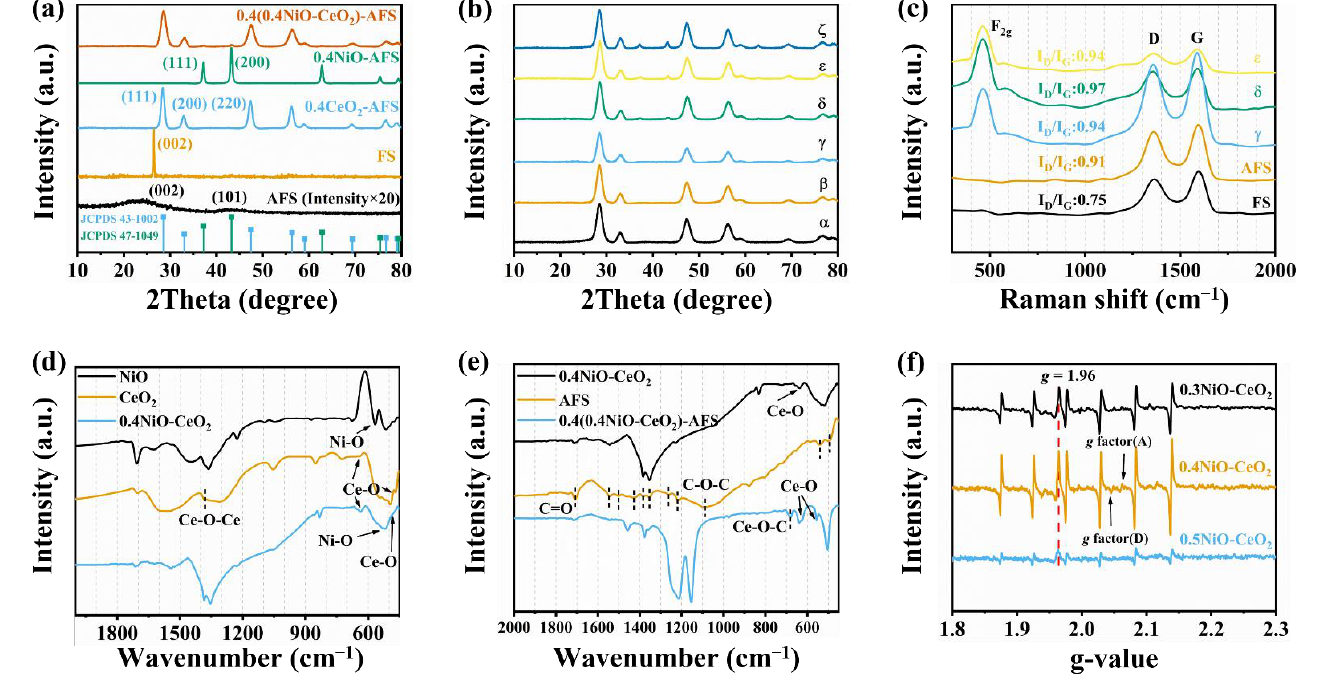
Figure 1. XRD patterns ( a , b ), Raman spectra ( c ), FT-IR spectra ( d , e ), and EPR spectra ( f ) of different samples. α − ζ are y values from 0.1 to 0.6 in 0.4(yNiO − CeO 2 ) − AFS, respectively.